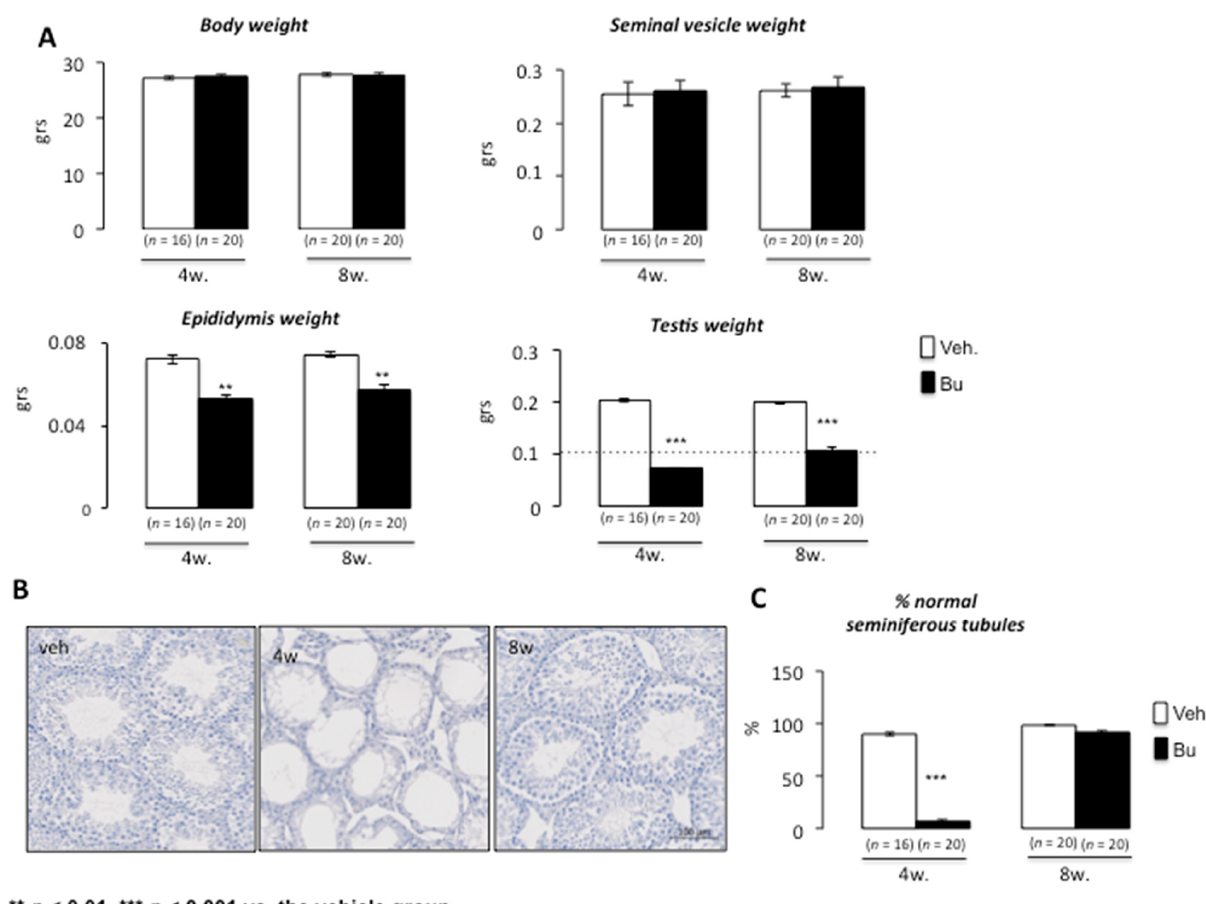
Figure 1. Acute busulfan exposure alters testes in male mice. ( A ) Body, seminal vesicle, epididymis, and testis weights of C57BL/6J males 4 or 8 weeks after busulfan or vehicle treatments. ( B ) Representative micrographs of hematoxylin/eosin-stained testes of C57BL/6J males 4 or 8 weeks after busulfan or vehicle treatments. ( C ) The number of normal seminiferous tubules of C57BL/6J males treated with the vehicle or busulfan (4 or 8 weeks after treatment). For all panels, the data were obtained from at least three independent experiments; the number of animals per group is indicated in brackets below the bars of the graphs. The data are expressed as the means ± SEM. Statistical analysis: ** p < 0.01, and *** p < 0.001 vs. the vehicle group. Veh.: vehicle and Bu: busulfan.